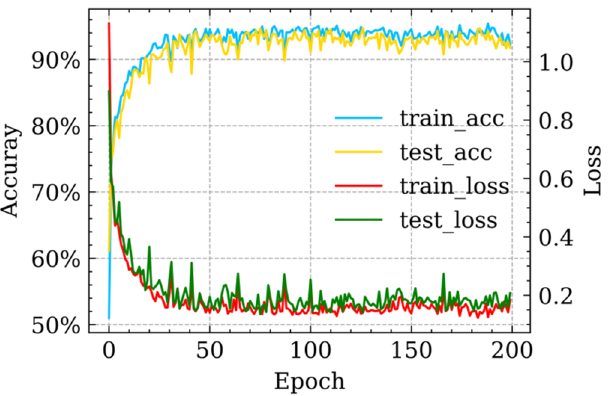
Figure 12. Accuracy and loss value of the Attention-TCN-BiGRU model test set and training set.